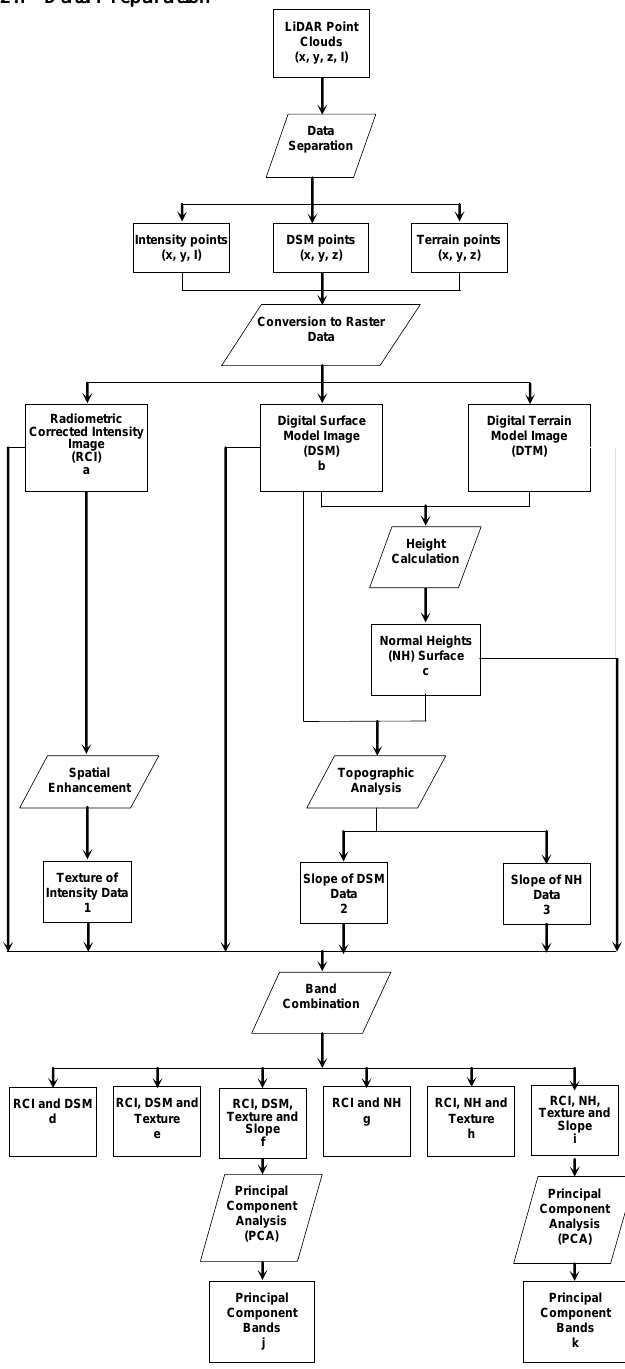
Figure 1: Work Flow of Data